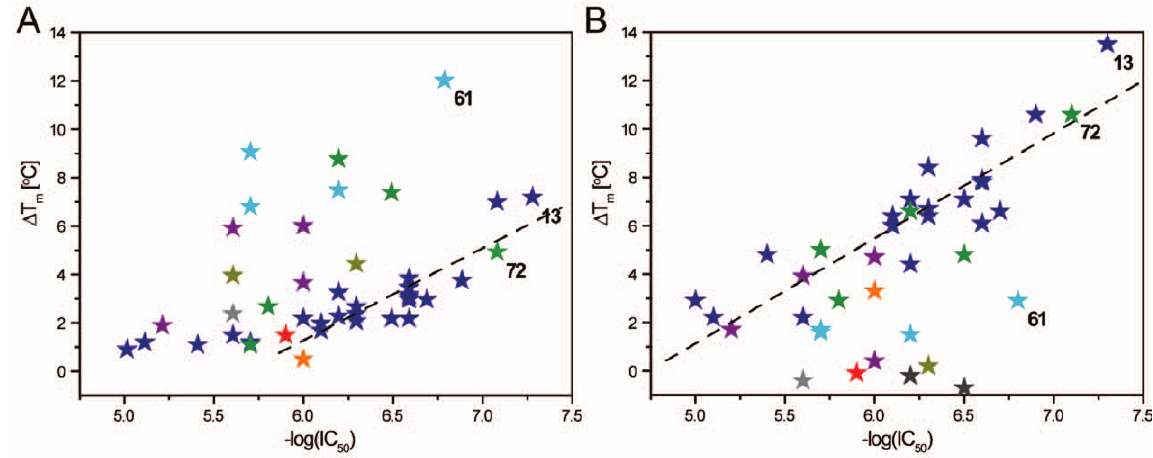
Figure 3. Correlation between thermal stabilization of 15-PGDH in presence of NAD + ( A ) or NADH ( B ) and inhibitory pIC 50 for screening hits from different structural clusters. Thermal stabilization is expressed as a shift in the midpoint of the unfolding transition of the protein ( D T m ). D T m and pIC 50 (-log(IC 50 ) values are means of at least three independent measurements. The inhibitors are represented by color-coded symbols according to their chemical clusters, respectively (supplementary information Table S1): blue, cluster 1; dark green, cluster 2; orange, cluster 3; purple, cluster 4; light blue, cluster 5; light green, cluster 8; grey, cluster 9; dark yellow, cluster 11; red, singletons (a T m could not be determined for the tested compounds in clusters 6, 7 & 10). The dotted line in each graph A & B denotes correlations for the compounds in cluster 1, respectively. Numbers within the graphs assign the positions for the inhibitors of special interest (see text).